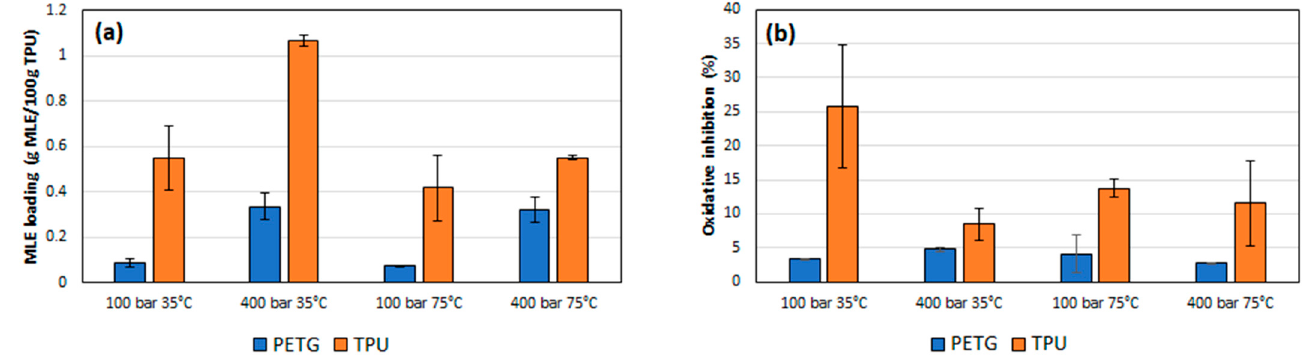
Figure 5. Mango leaves extract impregnation loading ( a ) and antioxidant activity of MLE impregnated polymers ( b ). Table 3. ANOVA table and Pareto chart for quadratic model of MLE loading in TPU.